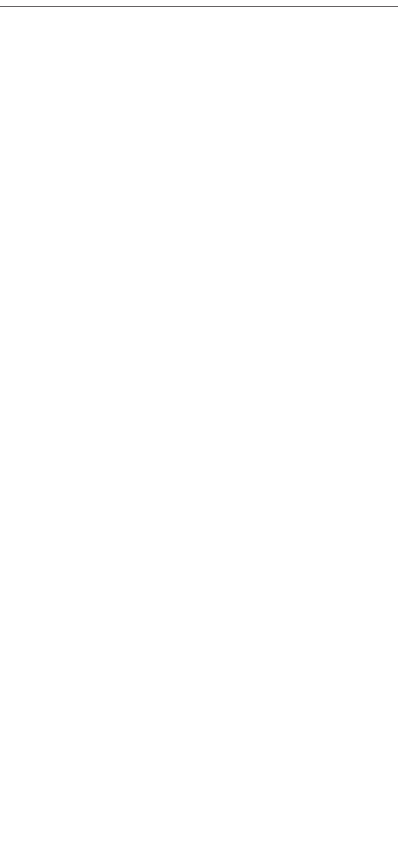
TABLE 1 | Patient demographics.